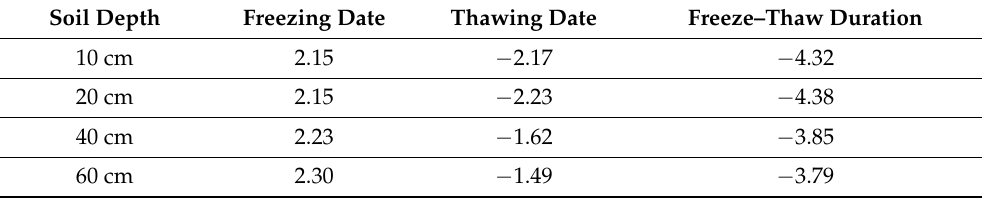
Figure 10. Trends in freezing date, thawing date, and freeze–thaw duration at two soil depths from 1980 to 2016 (unit: day/decade). Grid points with statistically significant anomalies at the 90% confidence level are denoted by an oblique line. Table 2. Trends in soil freeze–thaw processes at different soil depths (unit: day/decade).